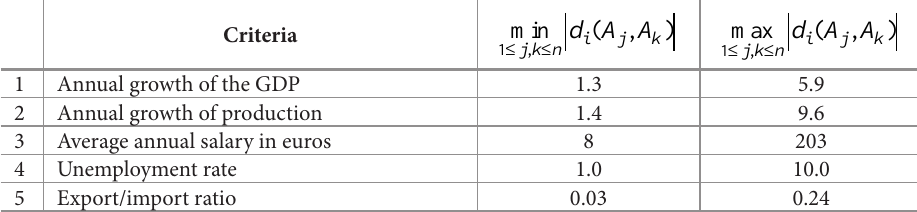
Table 2. The smallest and the largest modules of differences between given criteria